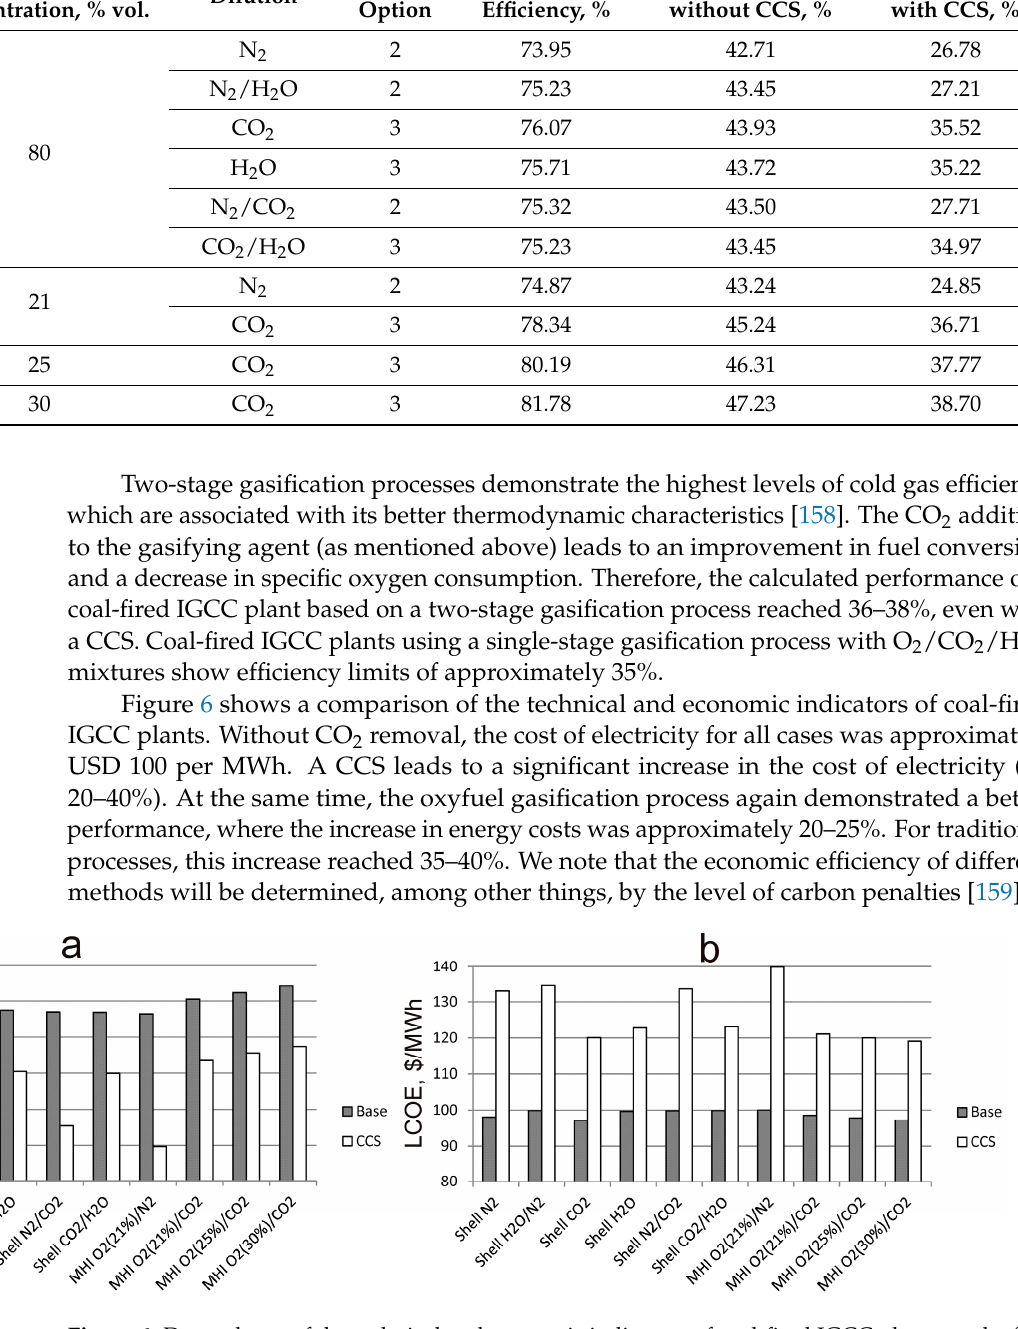
Figure 6. Dependence of the technical and economic indicators of coal-fired IGCC plants on the fuel gasification process: net efficiency ( a ) and cost of energy ( b ). The columns for the basic scheme are grey, and the columns for the CCS schemes are white.